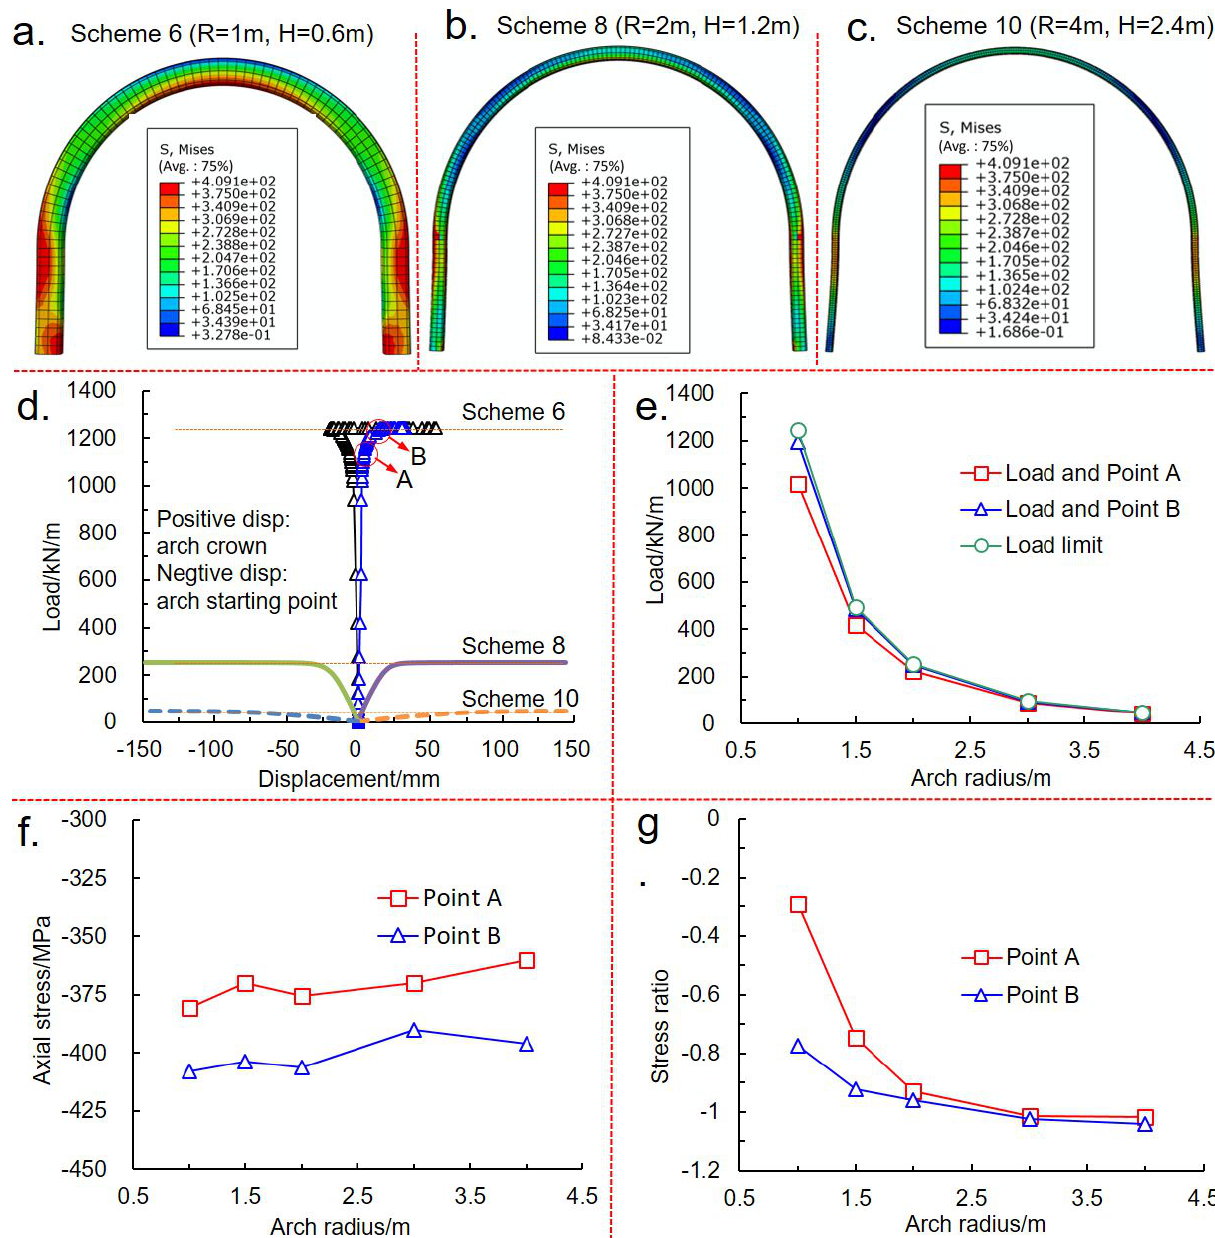
Figure 7: Typical results of Schemes 6–10 with different arch sizes. (a)–(c) Stress contours and deformed shapes of the arches; (d) Load– radial displacement curves; € Characteristic loads influenced by the arch size; (f) Axial stress at the dangerous section, influenced by the arch size; (g) Ratio of the axial stress at the inner and outer sides of the dangerous section, influenced by the arch